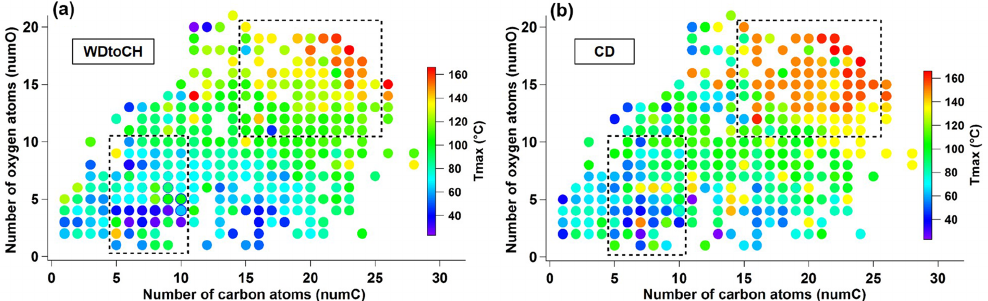
Figure 7. T max distribution for individual CHOI compounds of WDtoCH (a) and CD (b) experiments at t 0 according to number of oxygen atoms (numO) vs. number of carbon atoms (numC). Dashed boxes specify the compounds with nominal molecular formulae C 5 − 10 H y O 1 − 10 I − and C 15 − 25 H y O 11 − 20 I − that had bigger T max